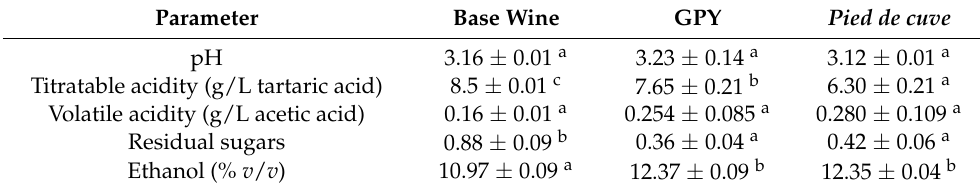
Table 1. Chemical parameters of the resulting sparkling wines fermented with the S. cerevisiae strain IOC 18-2007, GPY-grown or pied de cuve -prepared. Parameter Base Wine GPY Pied de cuve pH 3.16 ± 0.01 a 3.23 ± 0.14 a 3.12 ± 0.01 a Titratable acidity (g/L tartaric acid) 8.5 ± 0.01 c 7.65 ± 0.21 b 6.30 ± 0.21 a Volatile acidity (g/L acetic acid) 0.16 ± 0.01 a 0.254 ± 0.085 a 0.280 ± 0.109 a Residual sugars 0.88 ± 0.09 b 0.36 ± 0.04 a 0.42 ± 0.06 a Ethanol (% v / v ) 10.97 ± 0.09 a 12.37 ± 0.09 b 12.35 ± 0.04